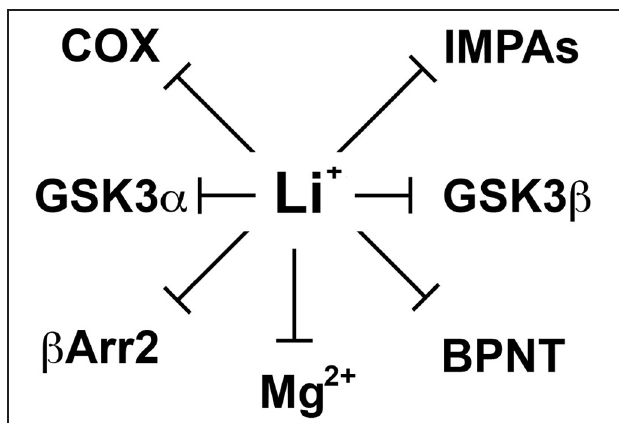
FIGURE 1 | Schematic representation of different direct molecular targets of lithium. These include inositol monophosphatases (IMPAs), Bisphosphate 3 (cid:2) -nucleotidase (BPNT), cyclooxygenase (COX), beta-arrestin 2 ( β Arr2), and members of the glycogen synthase kinase 3 alpha and beta (GSK3 α and β ). Since the mechanism by which lithium would inhibit several of these molecules is by competing with magnesium ions (Mg 2 + ) acting as a co-factor we also included the possibility that other molecular targets may be affected through such